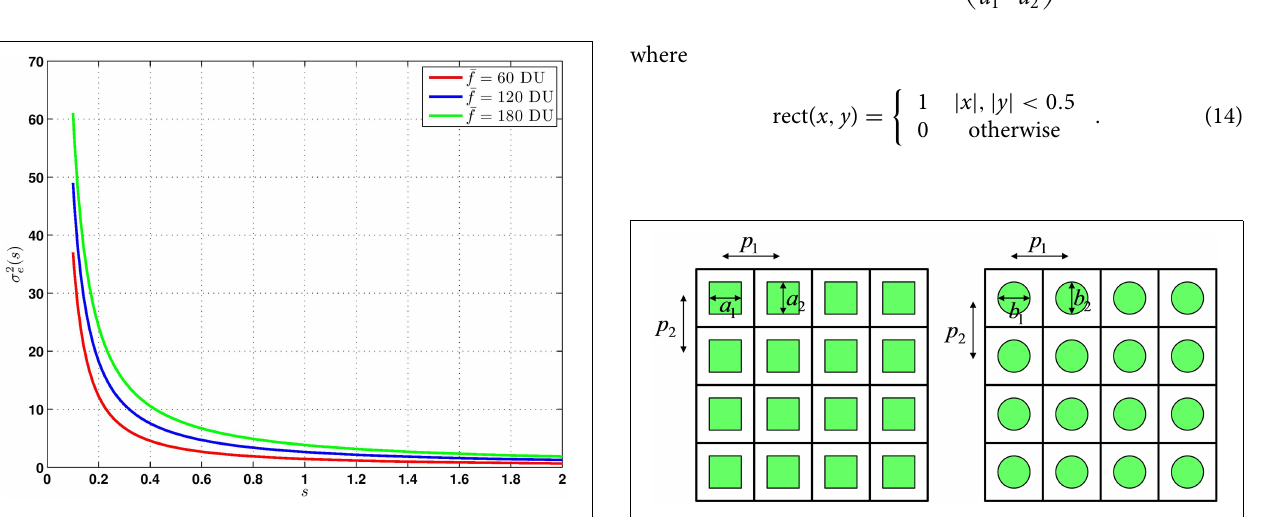
FIGURE 5 | Effective noise variance, σ 2 e ( s ) , as a function of signal scaling s , for three values of ¯ f for α = 0 . 02 , β = 0 . 00 , and σ 2 η = 0 . 50 .